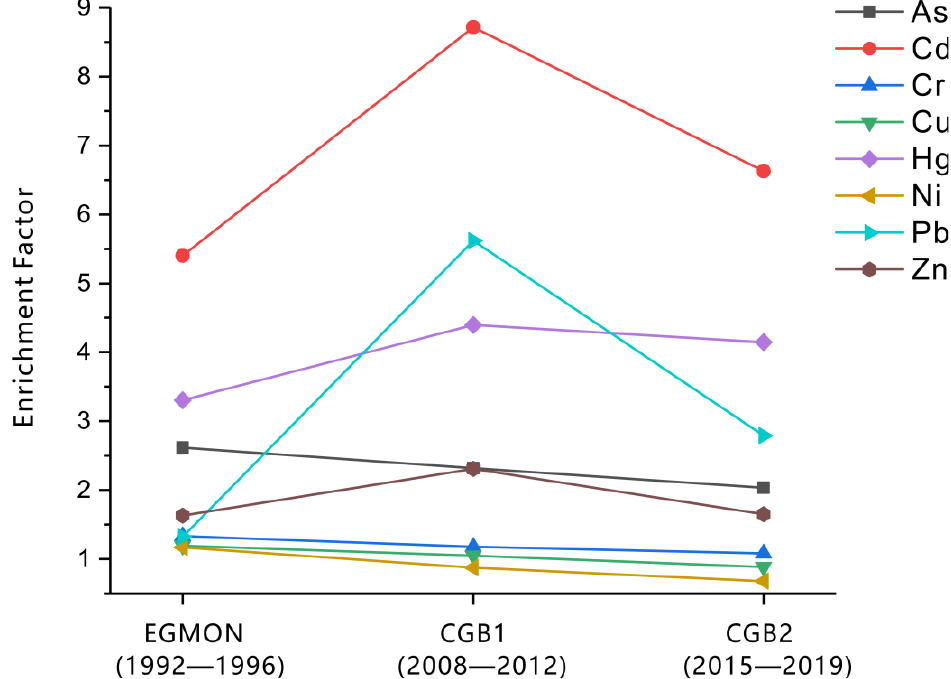
Figure 2. Degree of enrichment of toxic metals in catchment sediments.